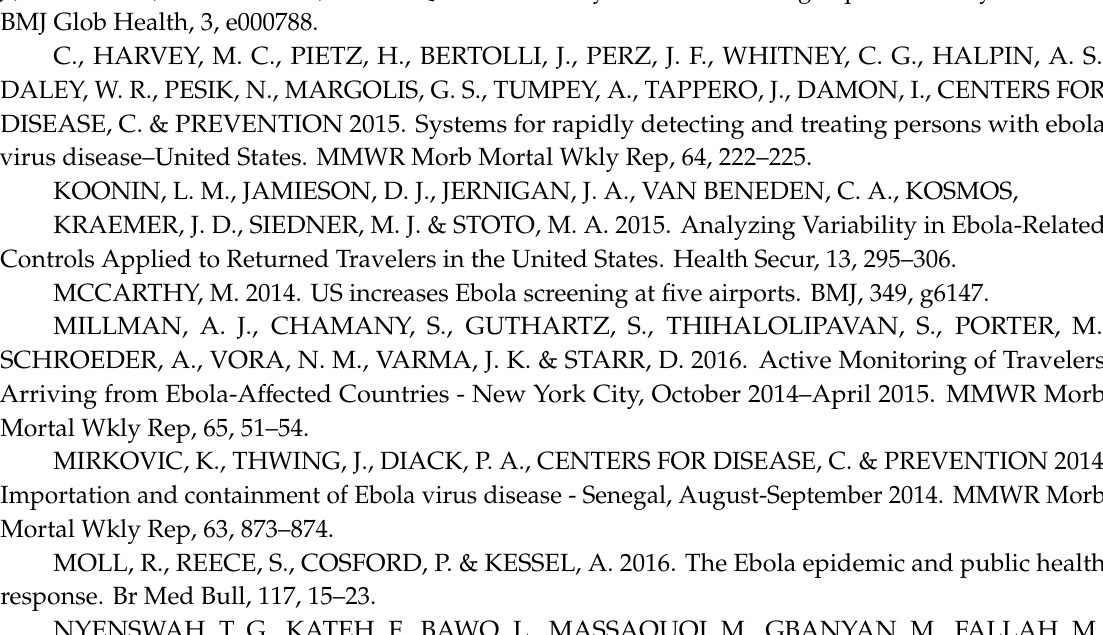
Interim Table of State Ebola Screening and Monitoring Policies for Asymptomatic